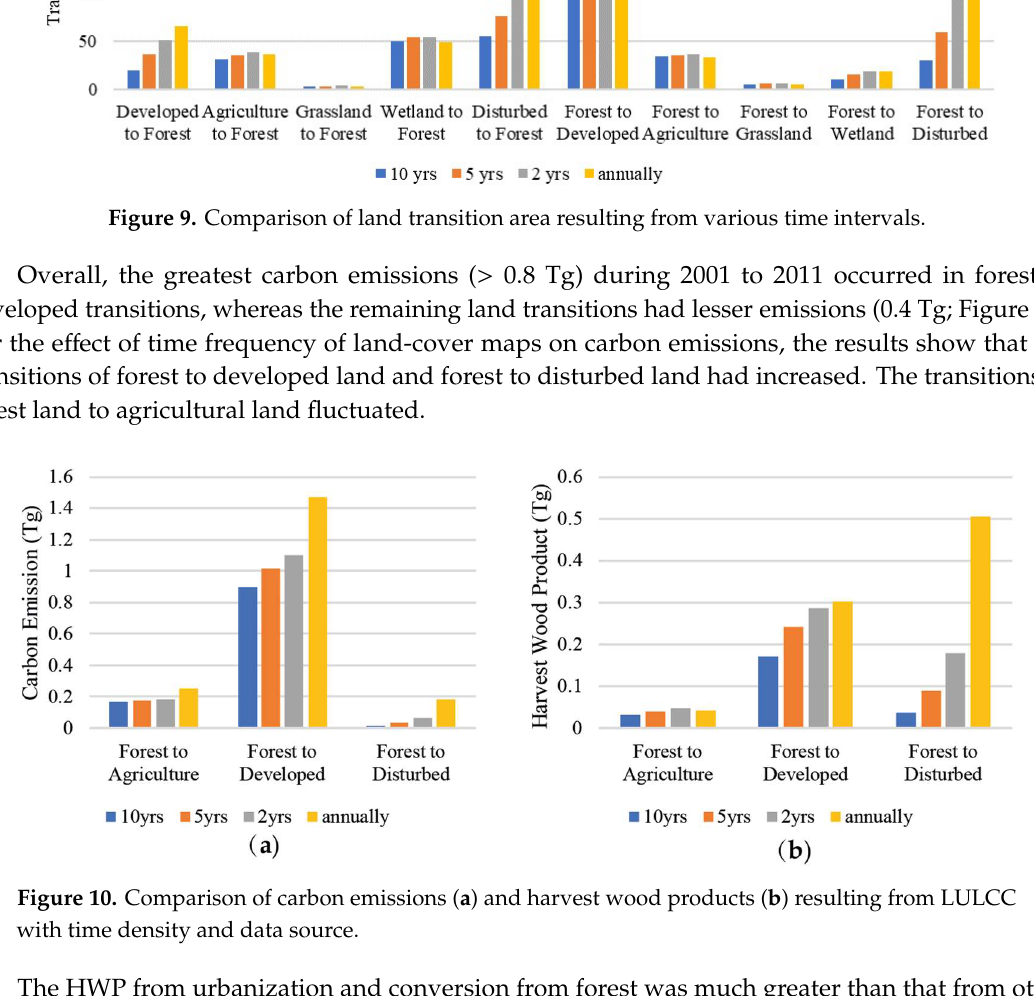
Figure 9. Comparison of land transition area resulting from various time intervals.